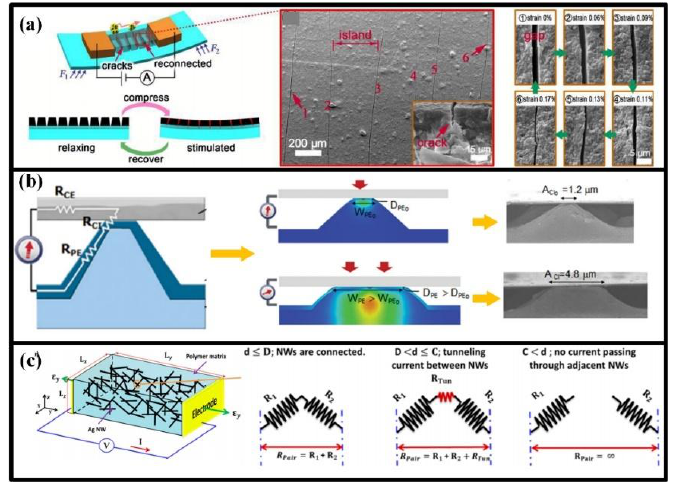
Figure 6. Available working concepts for piezoresistive wearable sensors: ( a ) micro-scale crack; ( b ) the connecting area between the active and electrode layers; ( c ) the connecting, disconnecting and tunneling effect between the adjacent active elements. Reproduced from [122] with permission of The Royal Society of Chemistry. Reproduced from [124] with permission of WILEY. Reprinted with permission from [35], Copyright (2014) American Chemical Society.